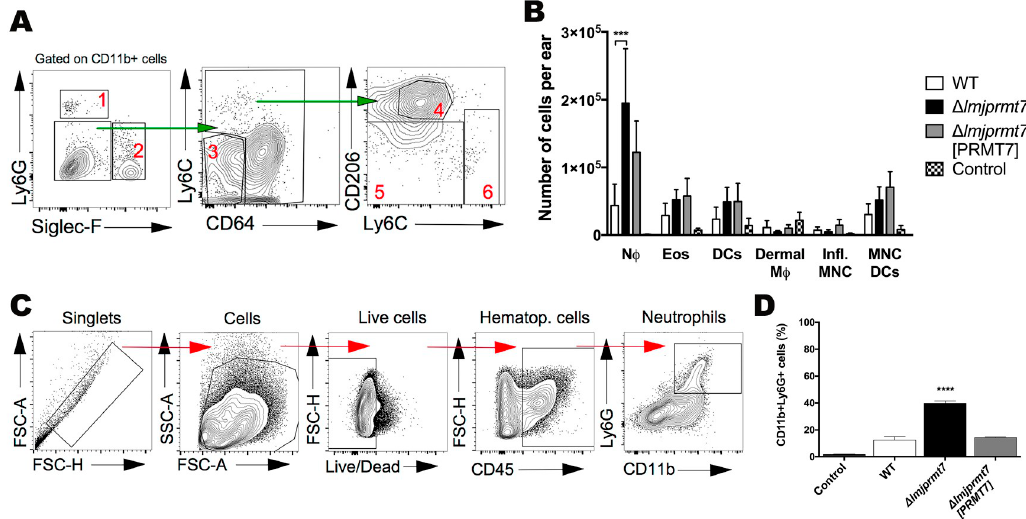
Fig 4. Subset of myeloid cells recruited to the site of infection after 7 weeks post-infection. BALB/c mice were infected in the ear dermis with 100,000 Lmj CC1 metacyclic promastigotes from the wild type, Δ lmjprmt7 and Δ lmjprmt7 [PRMT7] strains. Ear tissues were processed at 7 weeks post-infection to study the cell recruitment by flow cytometry. (A) Representative dot plots of ear-derived dermal cells. Subpopulations of myeloid (CD11b+) cells are defined as 1. Neutrophils, 2. Eosinophils, 3. Conventional dendritic cells, 4. Dermal macrophages, 5. Monocyte derived dendritic cells, 6. Inflammatory monocytes. (B) The number of cells in each myeloid cell subset after 7 weeks of infection (N F : neutrophils; Eos: eosinophils; DCs: dendritic cells; Dermal M F : dermal macrophages; Infl. MNC: inflammatory monocytes; MNC DCs: Monocyte derived dendritic cells). All data are shown as the mean ± SEM of twenty samples (five mice, per group) from two independent experiments ��� p < 0.001, using ordinary one-way ANOVA, with Dunn’s multiple comparison test. (C) The representative contour plot of another independent experiment and (D) the percentages of neutrophils (CD11b+Ly6G+ cells) after 7 weeks of infection.